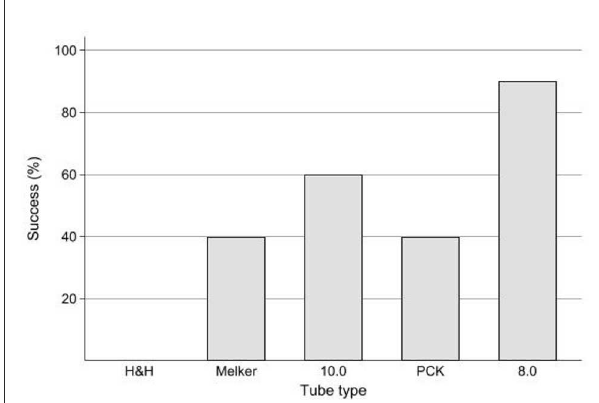
FIGURE2 Bar chart of successful airway seal (%) using the minimum occlusion volume technique with intra-cuff pressure ≤ 48cm H 2 O in five tubes used for cricothyrotomy in ten cadaver dogs. Success (%) describes a successful airway seal between tube cuff and trachea as defined as absence of audible air leak at a PIP of 15cm H 2 O and a cuff pressure of ≤ 48cm H 2 O. Tube type definitions: PCK–Portex ® PCK